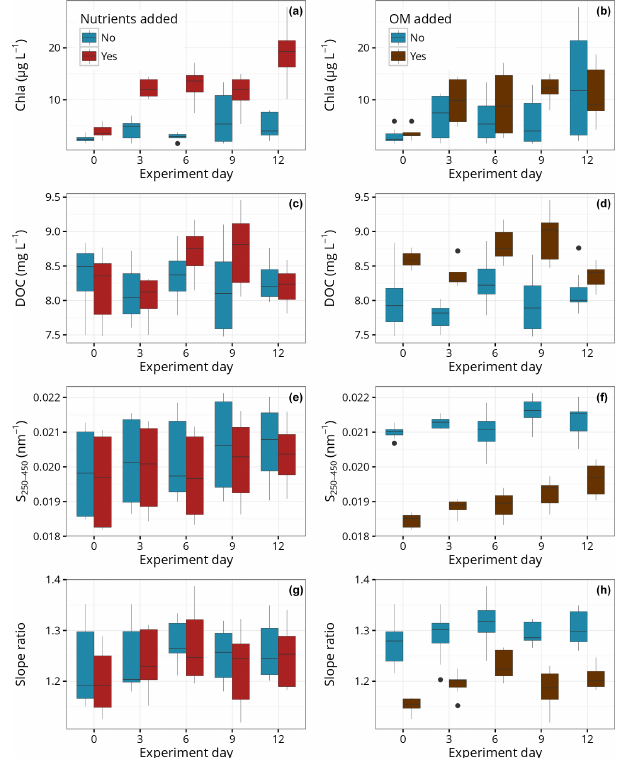
Figure 2. Temporal variation in the mesocosms units with and with- out nutrients (left column) and organic matter additions (right col- umn) for Chl a (a, b) , DOC (c, d) , S 250–450 (e, f) , and S R (g, h) (center line: median; 5th/95th percentiles; 95% confidence level; black circles: